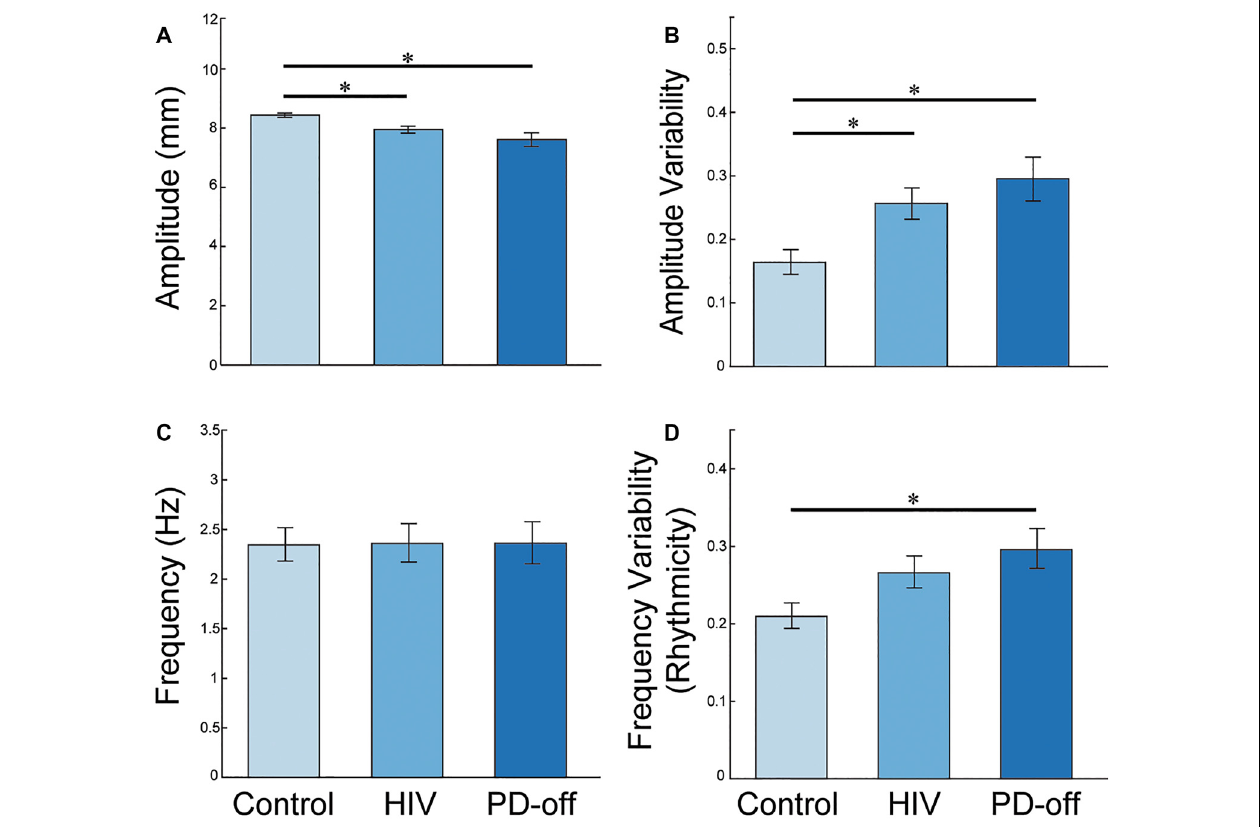
FIGURE 2 | MN Index Finger RAFT Measures. Post-hoc least significant differences (LSD) group comparisons of RAFT metrics in the MN index finger (the more affected side in PD subjects; Non-dominant hand in HIV and C subjects): (A) amplitude (distance the key travelled during a cycle of tapping from pressing down